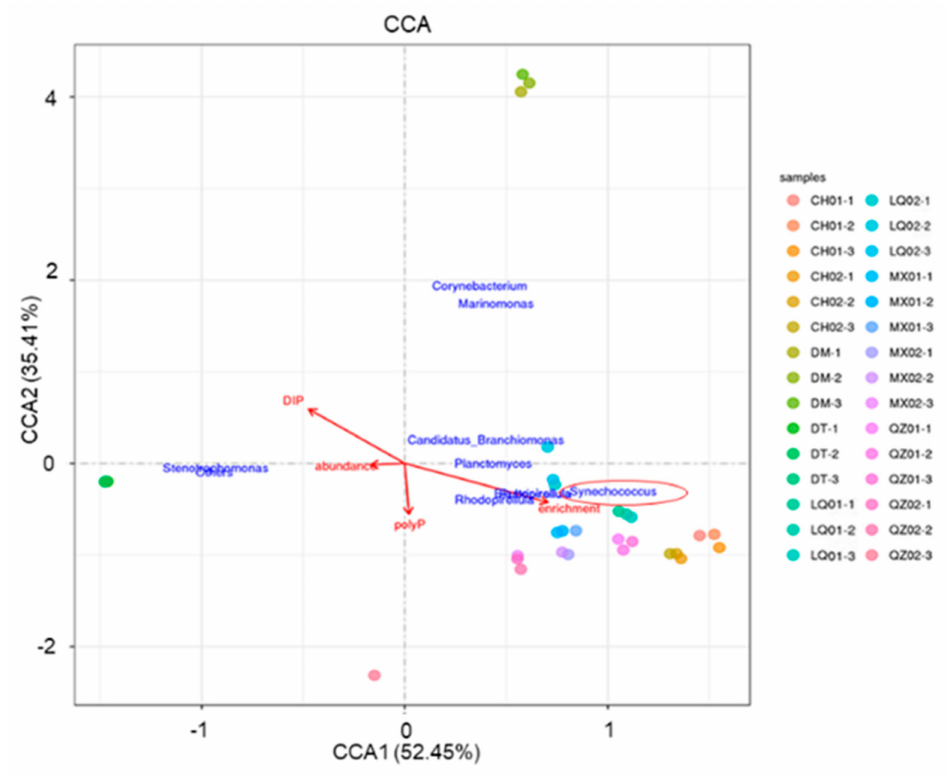
Figure 4. Canonical correspondence analysis (CCA) between the microbial community structure and four environment